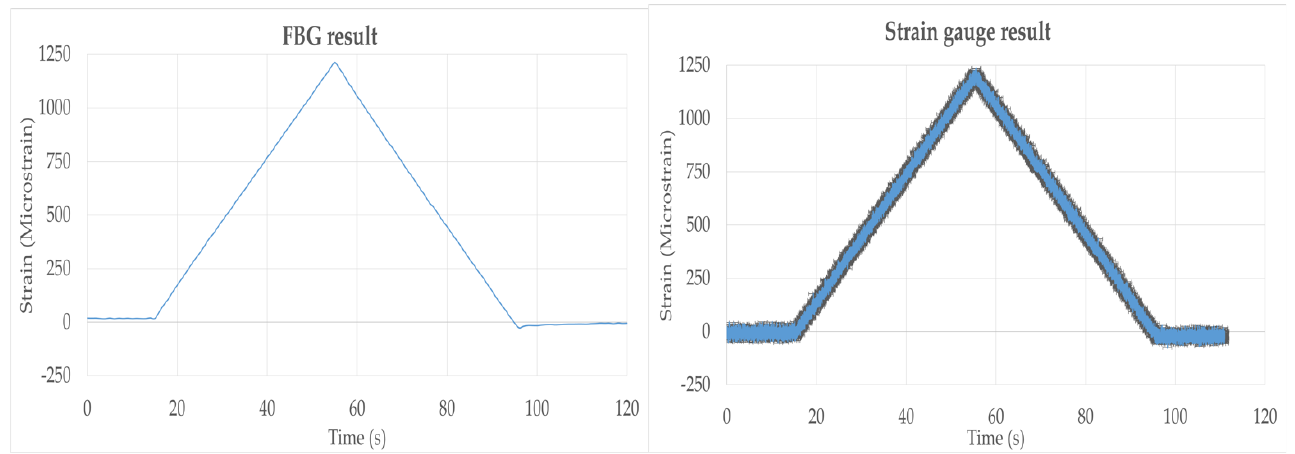
Figure 8. Strain signal output comparisons between FBG sensor and strain gauge.